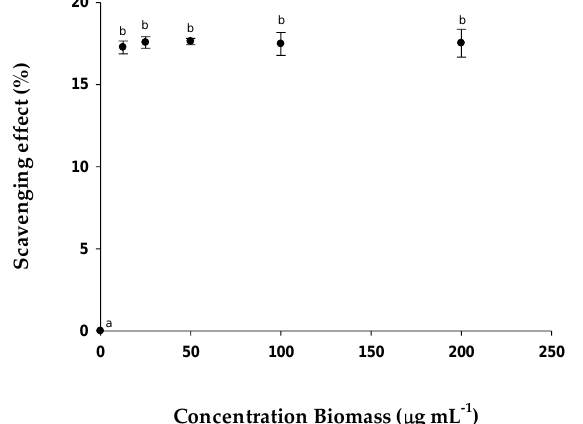
Figure 4. Scavenging effects % of the sample on DPPH radical. The data are the mean of 3 replicate measurements ± standard error. Similar letters (a or b) indicate no significant differences (Tukey, p < 0.05) between the different concentrations.